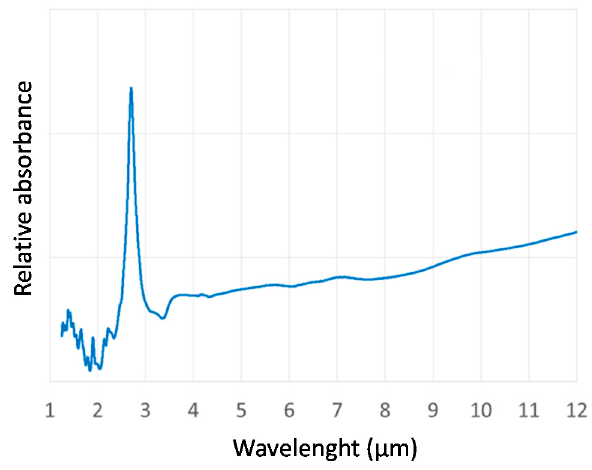
Figure 1. Hollow-core waveguide (HCW) relative absorbance measured in the range 1–12 μ m using a FTIR spectrometer.